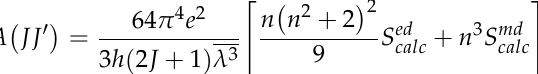
Table 3. Experimental ( f ed exp ) and calculated ( f ed Excited Energy